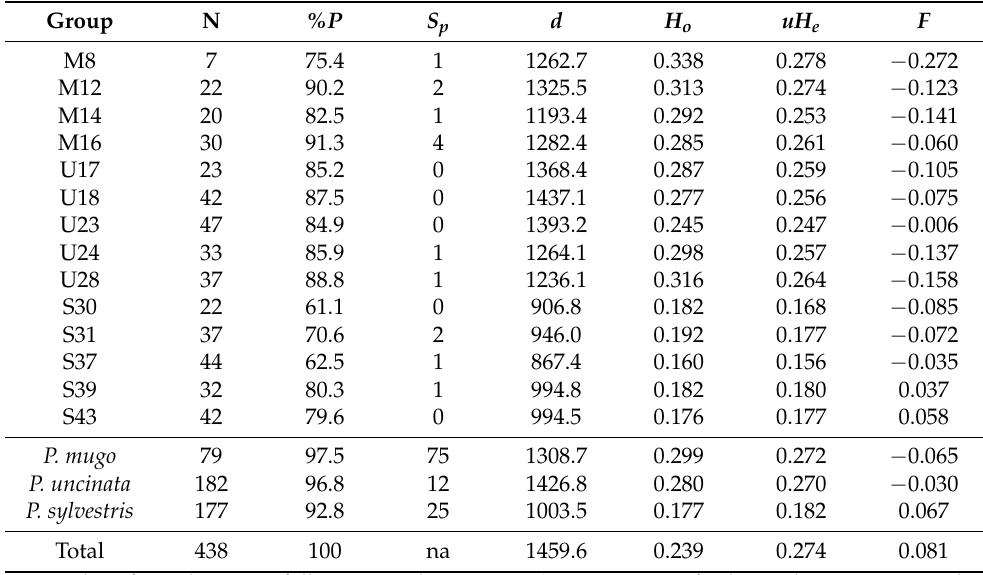
Table 1. Genetic variation estimates of 14 populations and three pine species investigated.